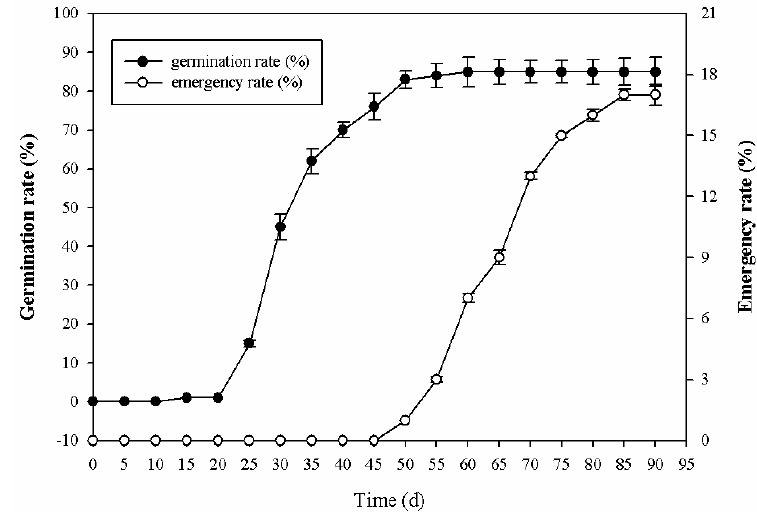
Figure 1. Seed germination rate and emergence rate of P. cyrtonema Hua.